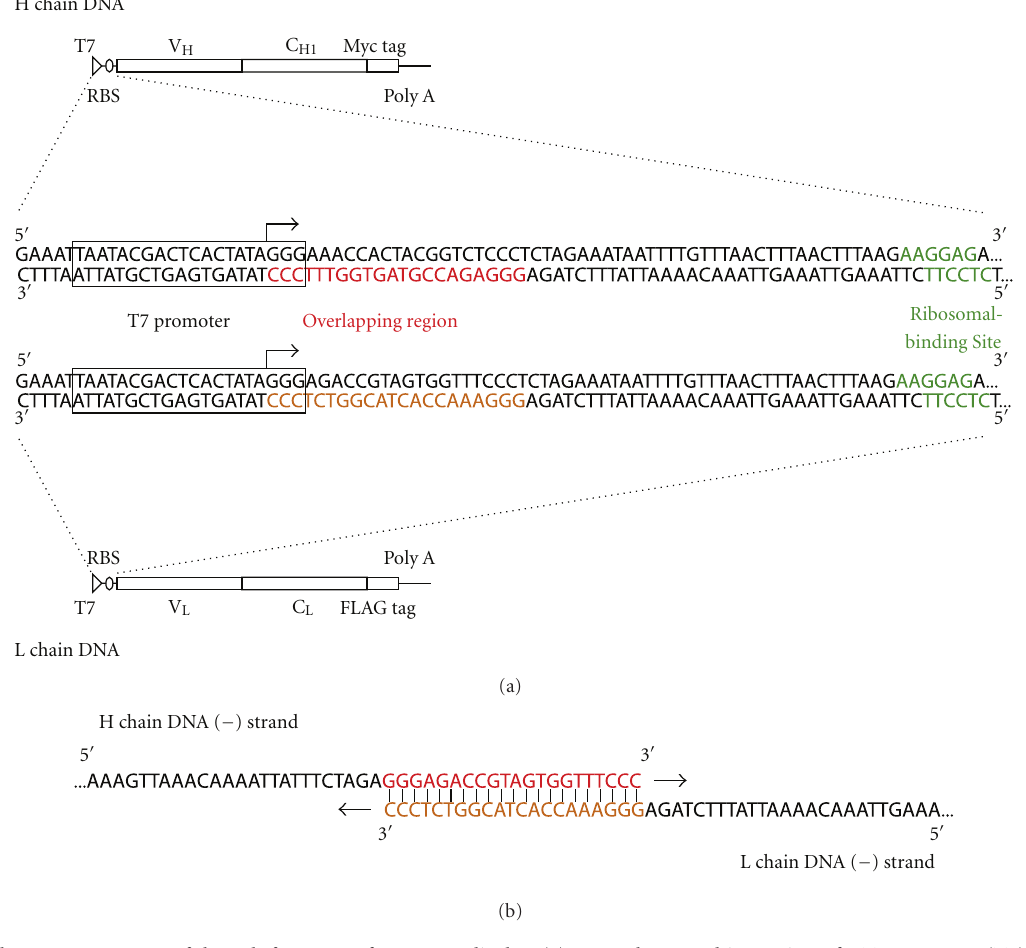
Figure 1: The DNA construct of the Fab fragments for mRNA display. (a) From the 5 (cid:2) end it consists of a T7 promoter (T7), ribosomal- binding site (RBS), variable region and constant region of the H chain or L chain, epitope tag, and a poly A tail. The H chain epitope tag is a Myc tag and the L chain is a FLAG tag. The poly A tail is for purification of mRNA-displayed molecules by biotin-oligo dT in combination with streptavidin beads. (Middle) Details of the linkable 5 (cid:2) UTR. Between the T7 promoter (boxed) and RBS (green), 21 bases from the beginning of T7 promoter transcription start point (arrow), in other words +1 to +21 of the H chain DNA (red) and L chain DNA (orange) are designed so that they overlap with each other during overlap-extension PCR. (b) The reverse-transcribed DNA strands overlap at the overlapping region (red) to form an H chain gene and L-chain-gene-linked